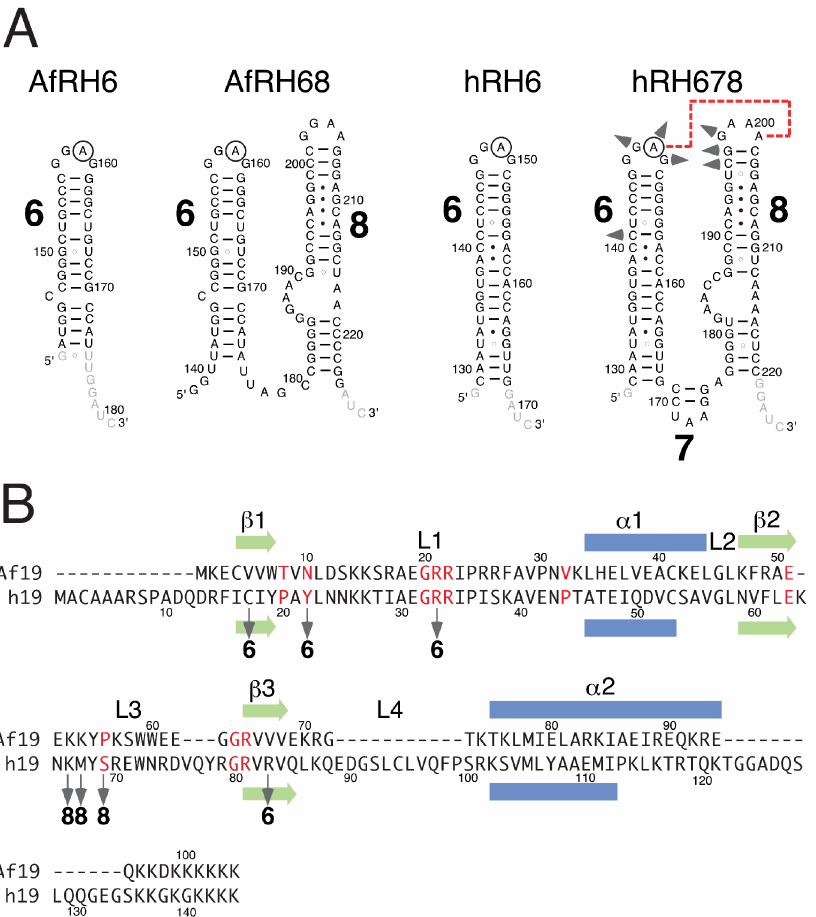
Figure 1. Structural features of the SRP components used in this study. (A) Secondary structures of A. fulgidus SRP RNA helix 6 (AfRH6) and a frag- ment comprising helices 6 and 8 (AfR- H68). The corresponding regions from the human SRP RNA (hSR) are repre- sented by hRH6 and hRH678. Nucleo- tides are numbered in increments of ten according to the full-length SRP RNA molecules. Residues deviating from the native sequences are shown in gray. The conserved adenosines targeted by site-directed mutagenesis are circled. Arrowheads in hRH678 mark nucleo- tides that are within 2.7 Å of SRP19 in the crystal structure of the ternary com- plex (coordinates are from 1MFQ.pdb). The red dashed line indicates the ter- tiary interaction between A149 and A201. (B) Sequence alignment of A. fulgidus SRP19 (Af19) and human SRP19 (h19). Residues are numbered in increments of ten. Conserved resi- dues are shown in red. In Af19, the α -helices, β -strands and loops are shown as in the solution structure of the free protein. Secondary structural features of the h19 are derived from 1MFQ.pdb and assigned as in the Pro- tein Data Bank (Bourne et al. 2004). Arrows indicate residues located within 2.7 Å of hSR helix 6 or helix 8 in the crystal structures of the ternary